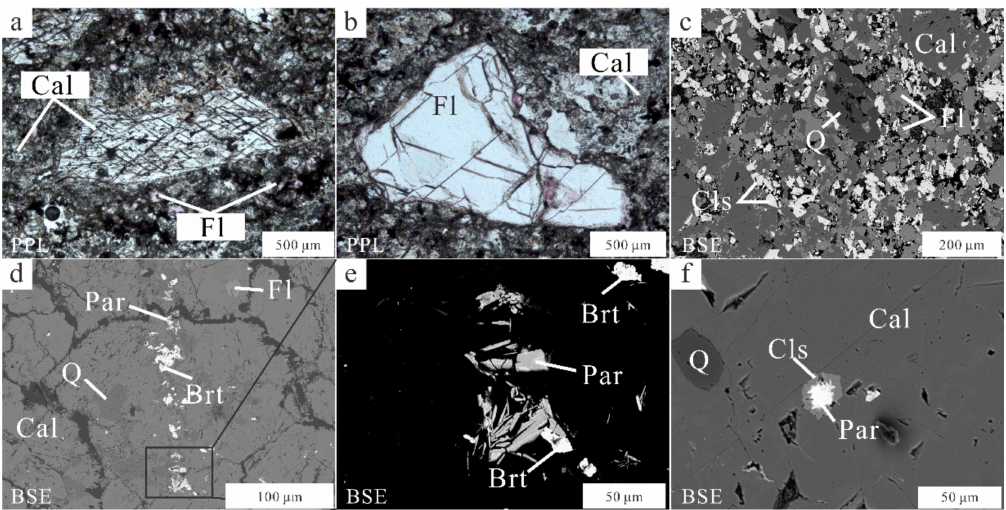
Figure 5. Transmitted plane-polarized light and back-scattered electron photomicrographs illustrating the key petrographic features of carbonatite and calcite. ( a ) Euhedral coarse-grained calcite (Cal) with jagged grain boundaries associated with fine-grained calcite and purple fluorite (Fl); ( b ) coarse-grained fluorite associated with fine-grained calcite; ( c ) calcite, fluorite, celestine (Cls) with accessory quartz; ( d , e ) barite (Brt) associated with quartz and parasite (Par) disseminated in calcite; ( f ) parasite together with celestine occurring as inclusions in